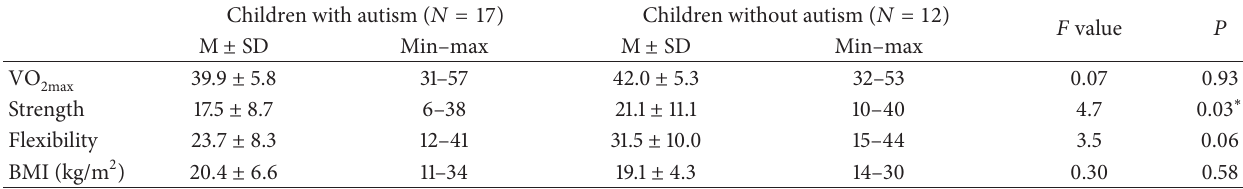
Table 2: Physical fitness by